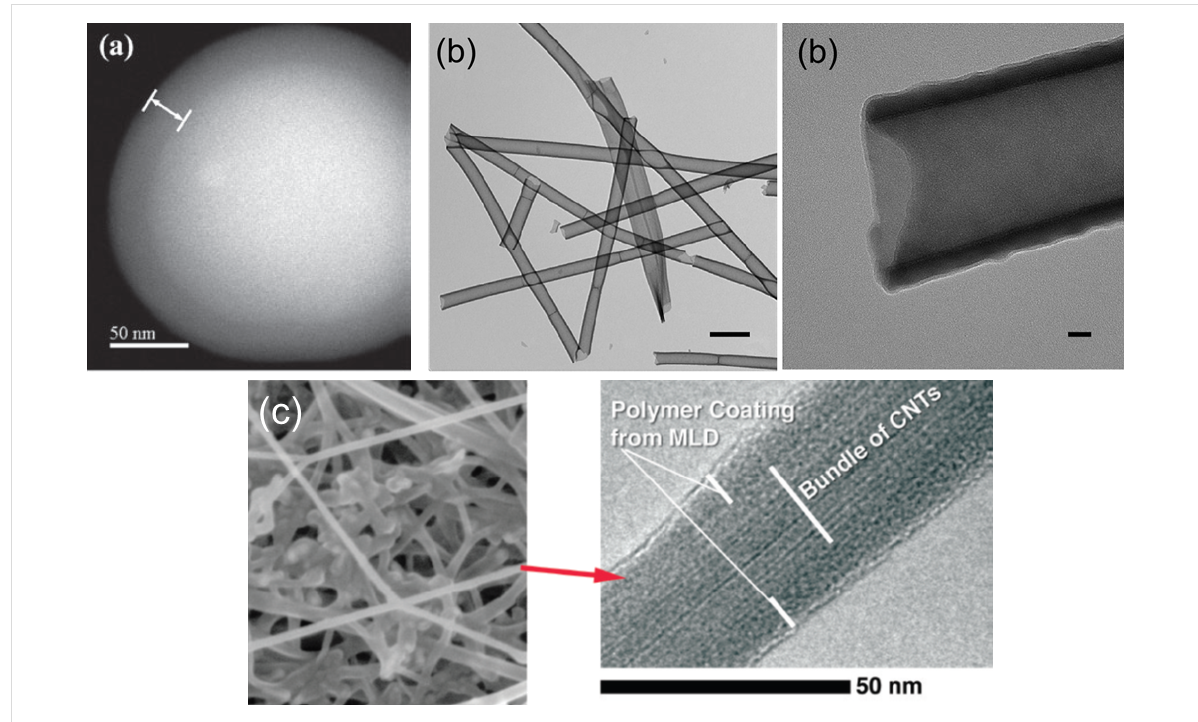
Figure 10: Electron microscope images of (a) 250 nm silica particles coated with a 25 nm thick layer of TMA+EG (reprinted with permission from [15], Copyright (2009) The Royal Society of Chemistry), (b) TMA+GLY film deposited on electro-spun polyvinyl alcohol fibers and annealed at 400 °C for 48 h (reprinted with permission from [38], Copyright (2011) American Chemical Society), and (c) metalcone coated carbon nanotubes (reprinted with permission from [95], Copyright (2013) American Chemical